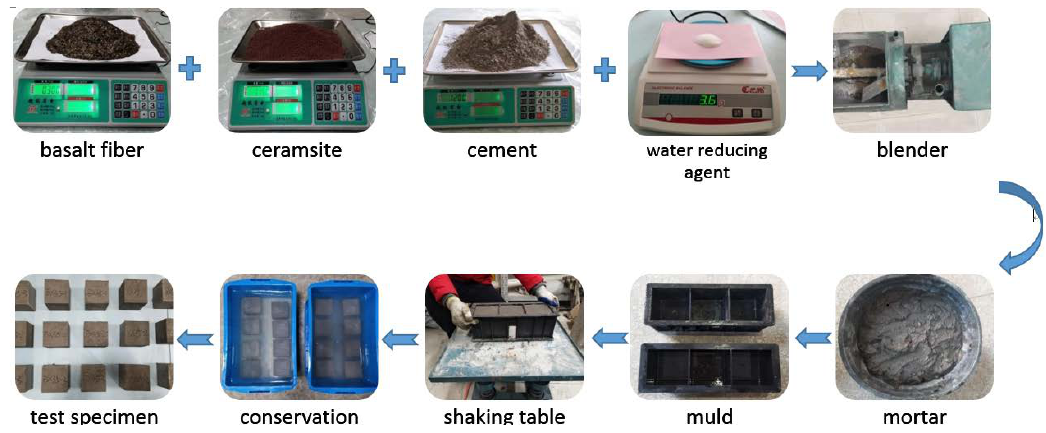
Figure 1. Flow chart of test specimen making.